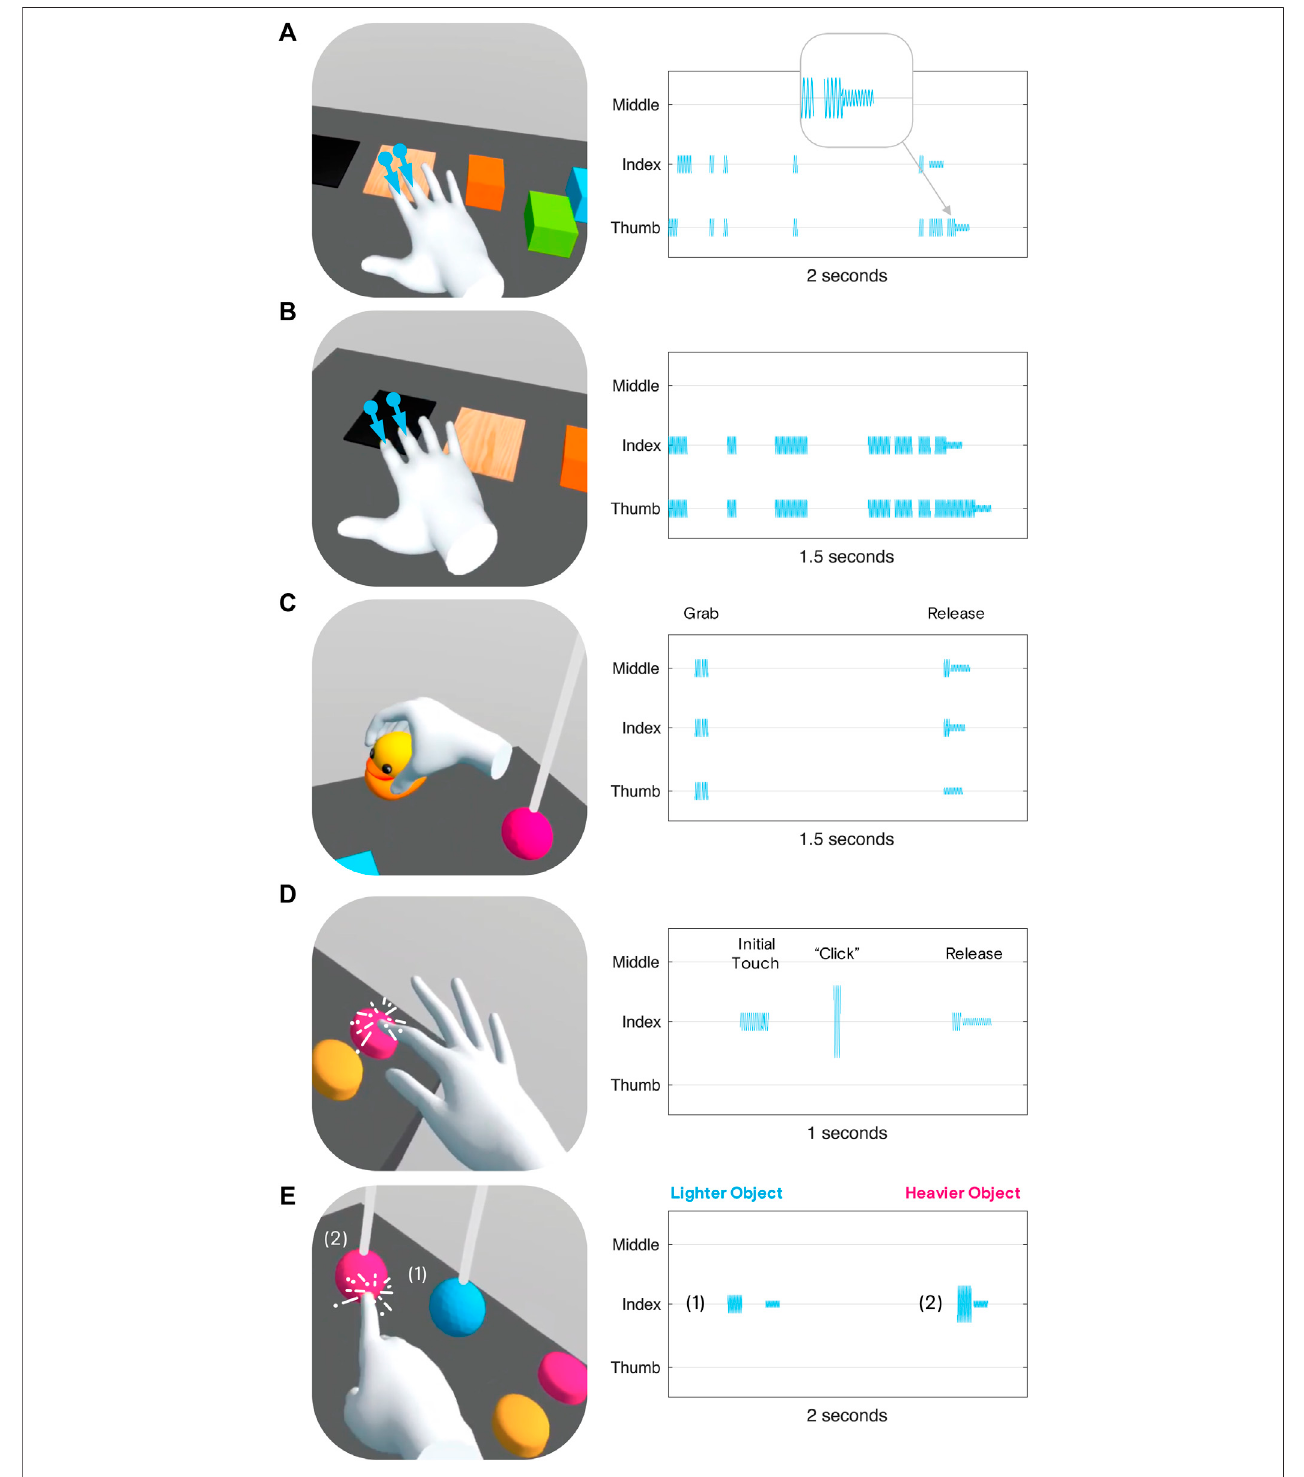
FIGURE 5 | Haptic rendering output, shown as waveforms, during a time window of interaction in the following scenarios: (A) dragging fi ngers across wood, (B) dragging fi ngers across smooth plastic, (C) picking up and letting go of a plastic toy, (D) pressing a button, and (E) prodding two similar spheres with different masses.